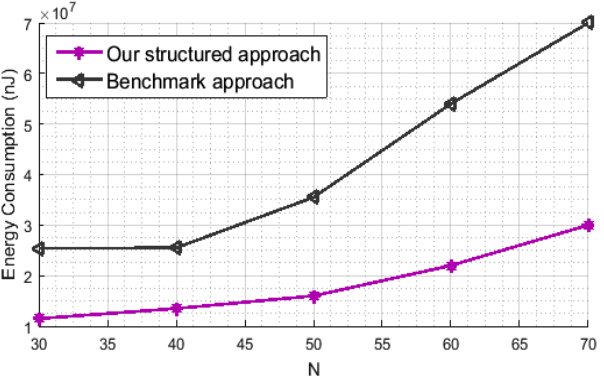
Figure 9. Energy consumption for the proposed technique and for the